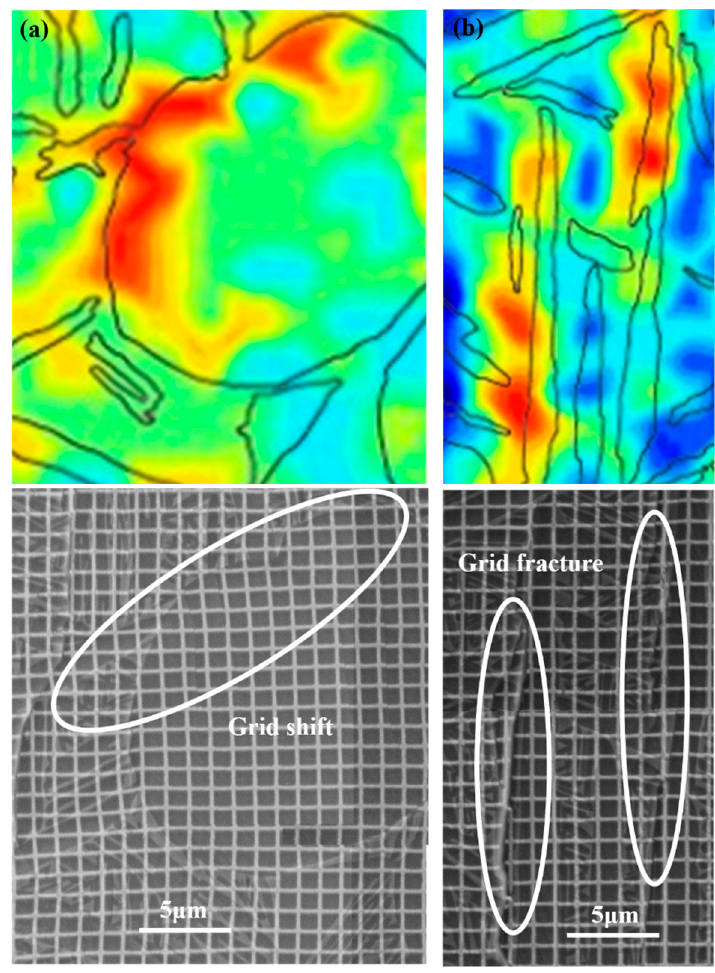
Figure 9. The typical strain localization regions and corresponding grid change at the boundary of α p / β t ( a ) and the boundary of α l / β t ( b ) at macro-strain of 4.7%.